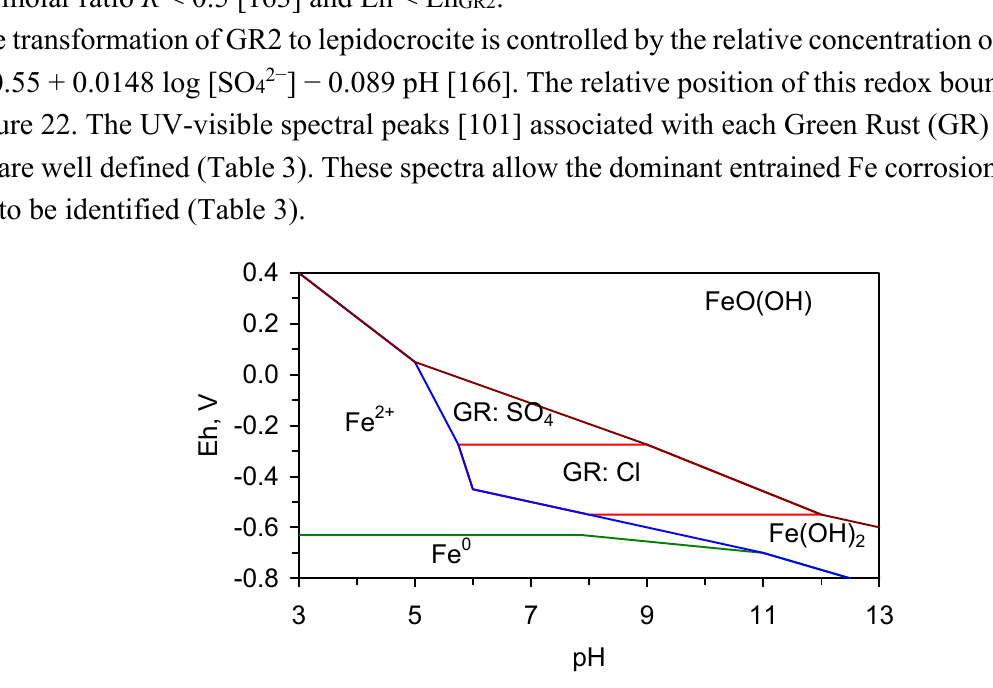
Figure 22. Pourbaix diagram showing the Eh, pH regions where the dominant